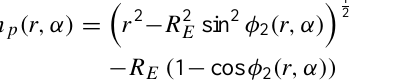
Fig. 6. A simple schematic diagram illustrating the concept of pseudo virtual height for 1 1 represents the surface of the Earth in the plane of the propagation path, the solid black line represents a virtual propagation path, the solid red line represents a refracted propagation path, the dashed black and red lines are perpendicular to the Earth’s surface, passing through the virtual and refracted ray scattering points, respectively, and the dotted blue line is the horizon. The solid blue line represents the pseudo virtual propagation path. (see text for full